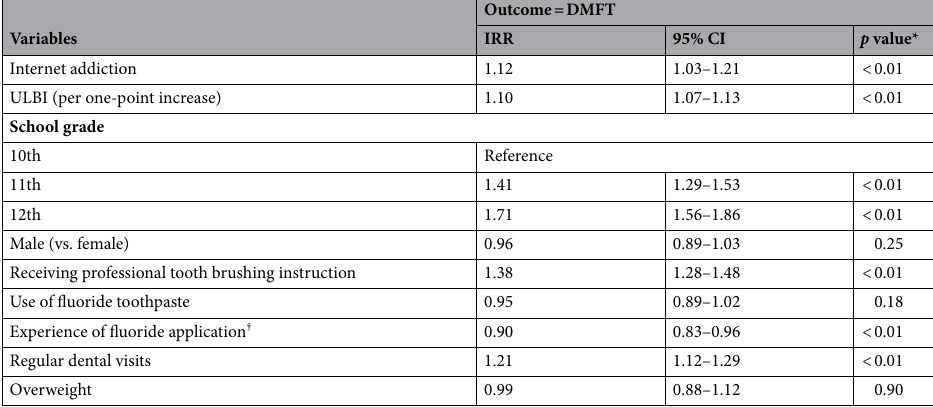
Table 2. Poisson regression analysis for the crude associations of dental caries with internet addiction, the unhealthy lifestyle behavior index, and other factors (N = 1562). CI confidence interval, DMFT number of decayed, missing, and filled permanent teeth, IRR incidence rate ratio, ULBI unhealthy lifestyle behavior index. *Except for unhealthy lifestyle score, grade, and sex, IRRs and CIs of being positive are presented. † Either a professional topical fluoride application or fluoride mouth rinse.